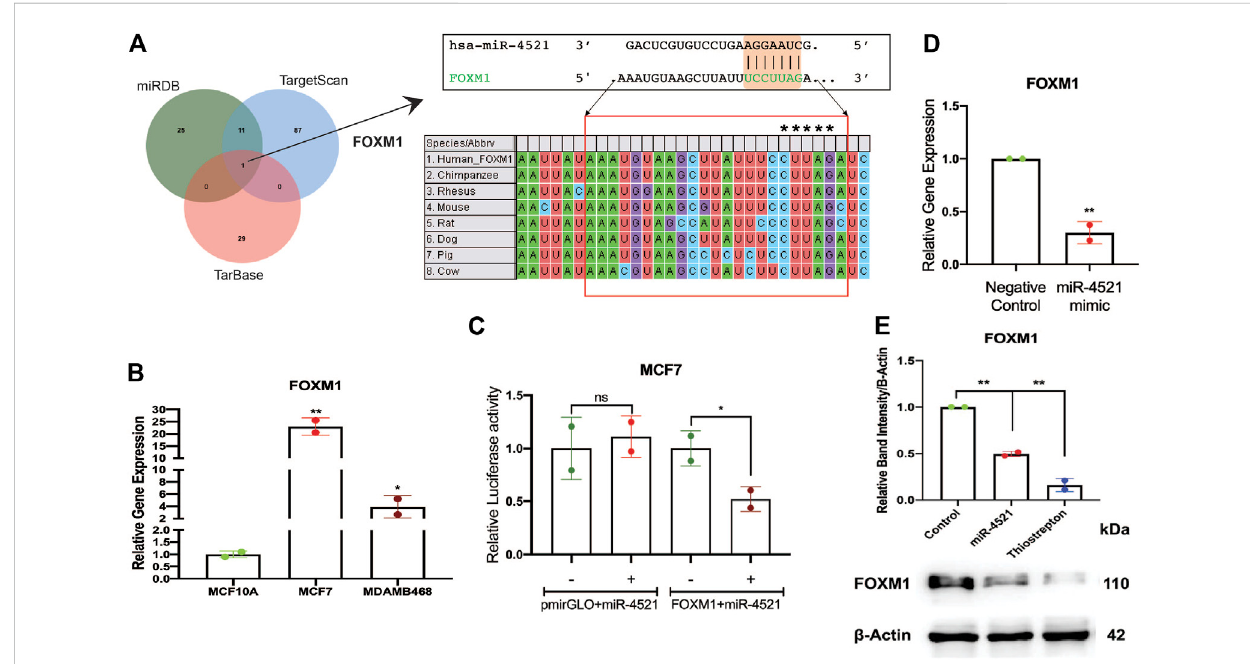
FIGURE 2 miR-4521 downregulates FOXM1 expression in breast cancer. (A) Target gene prediction for miR-4521 in three different target prediction tools: miRDB, TargetScan, and TarBase to identify putative mRNA targets. Top 10% of the targets from each tool were analyzed for common target gene and FOXM1 was identi fi ed as target for miR-4521. Binding between miR-4521 seed region sequence with the 3 ′ UTR of FOXM1 mRNA sequence was conserved amongmammals. (B) qRT-PCR expression analysisof FOXM1 mRNA showed high expression in MCF-7and MDA-MB-468 breastcancer cells compared to MCF-10A cells, β -Actin was used as endogenous control, relative quantity (RQ) was calculated using the formula 2 − ΔΔ CT ; paired Student ’ s t -test(two-tailed)wasperformedbetweencontrolMCF-10Aandeachbreastcancercelllines,* p < 0.05,** p < 0.001,( n =2). (C) Dual-luciferase reporter assay upon co-transfection of 3 ′ UTR of FOXM1 mRNA sequence cloned pmirGLO vector along with miR-4521 mimic or negative control oligos in MCF-7 cell lines after 24 h. Relative luciferase activity was calculated upon normalizing the activity of luciferase enzyme to Renilla-luciferase enzyme activity; paired Student ’ s t -test (two-tailed) was performed between negative control and miR-4521 transfected groups; (+) and ( − ) signs indicate presence and absence of miR-4521 mimics respectively; * p < 0.05, ( n = 3). (D) qRT-PCR analysis of FOXM1 mRNA upon transfection of miR-4521 mimic for 24 h in MCF-7 cell lines. β -Actin was used as endogenous control, relative quantity (RQ) was calculated using the formula 2 − ΔΔ CT ; paired Student ’ s t-test (two-tailed) was performed between negative control and miR-4521 transfected groups, ** p < 0.001, ( n = 3). (E) Western blot analysis of target FOXM1proteinabundanceupon50 nMofmiR-4521mimictransfectedand1 µMofThiostreptontreatmentaspositivecontrolinMCF-7celllines;paired Student ’ s t -test (two-tailed) was performed between negative control and miR-4521 transfected groups or negative control and thiostrepton treated groups, ** p < 0.001, ( n =